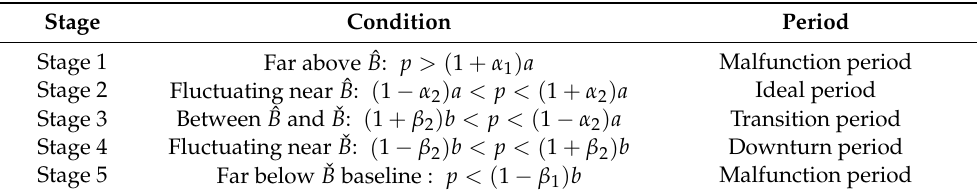
Table 2. Five conditions of power data and corresponding